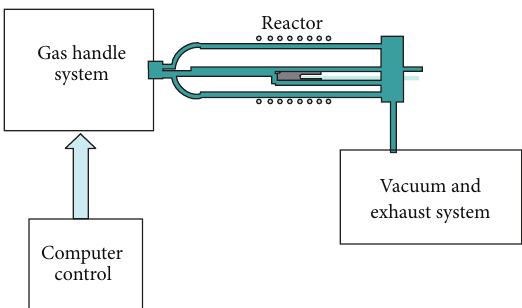
Figure 1: Schematic representation of MOCVD growth